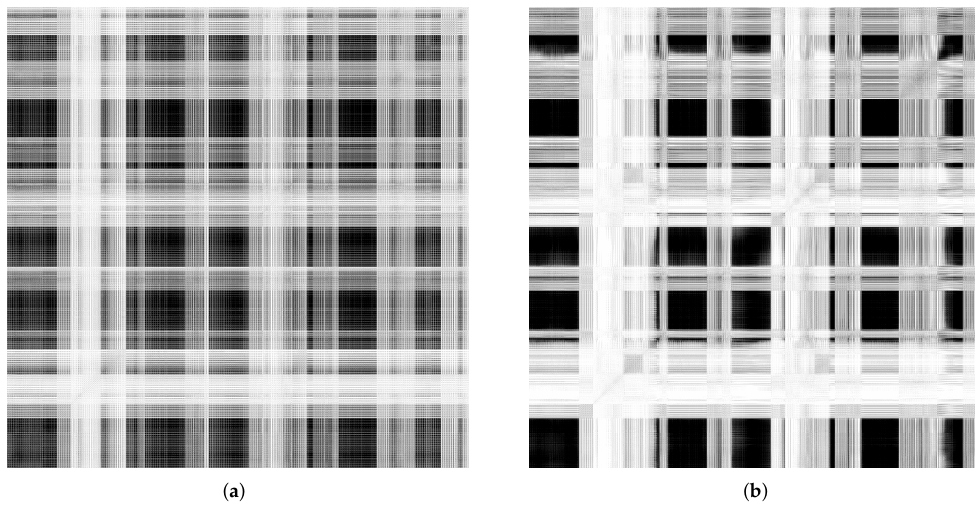
Figure 11. Recurrence plots using Florence3D dataset and setting optimal S R at 0.99 and I S at 0.09. ( a ) Self-organizing reservoir with RQA metrics: L MAX = 5874, LAM = 0.999980, DET = 0.999999, RR = 0.998964; ( b ) Randomly initialized with RQA metrics: L MAX = 5075, LAM = 0.998944, DET = 0.999626, RR =